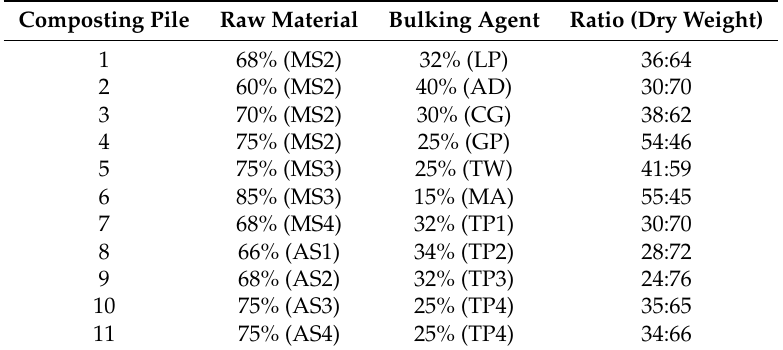
Table 1. Proportions of feedstocks and bulking agents in the composting treatments. Composting Pile Raw Material Bulking